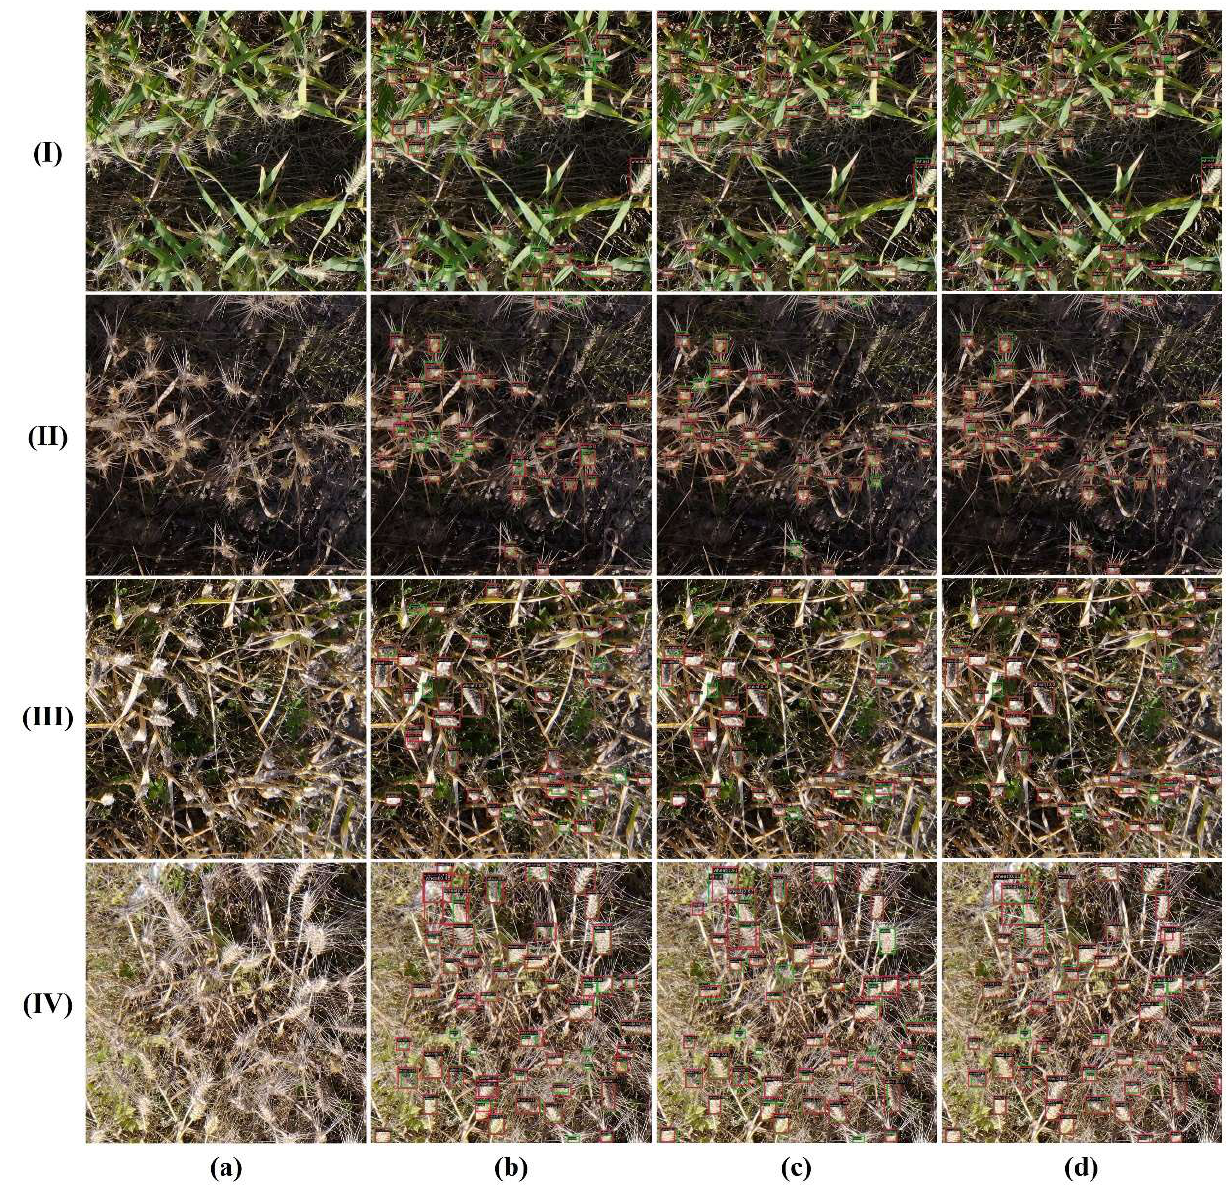
Figure 6. Detection results of UWHD ( a ) RGB image, ( b ) R-Transformer, ( c ) Y-Transformer, ( d ) FR- Transformer and the challenges are ( I ) different growth stage, ( II ) brightness variation, ( III ) image blur, and ( IV ) overlapping (the green bounding box in the image represents the ground truth of the wheat head, and the red bounding box represents the predicted wheat head region).